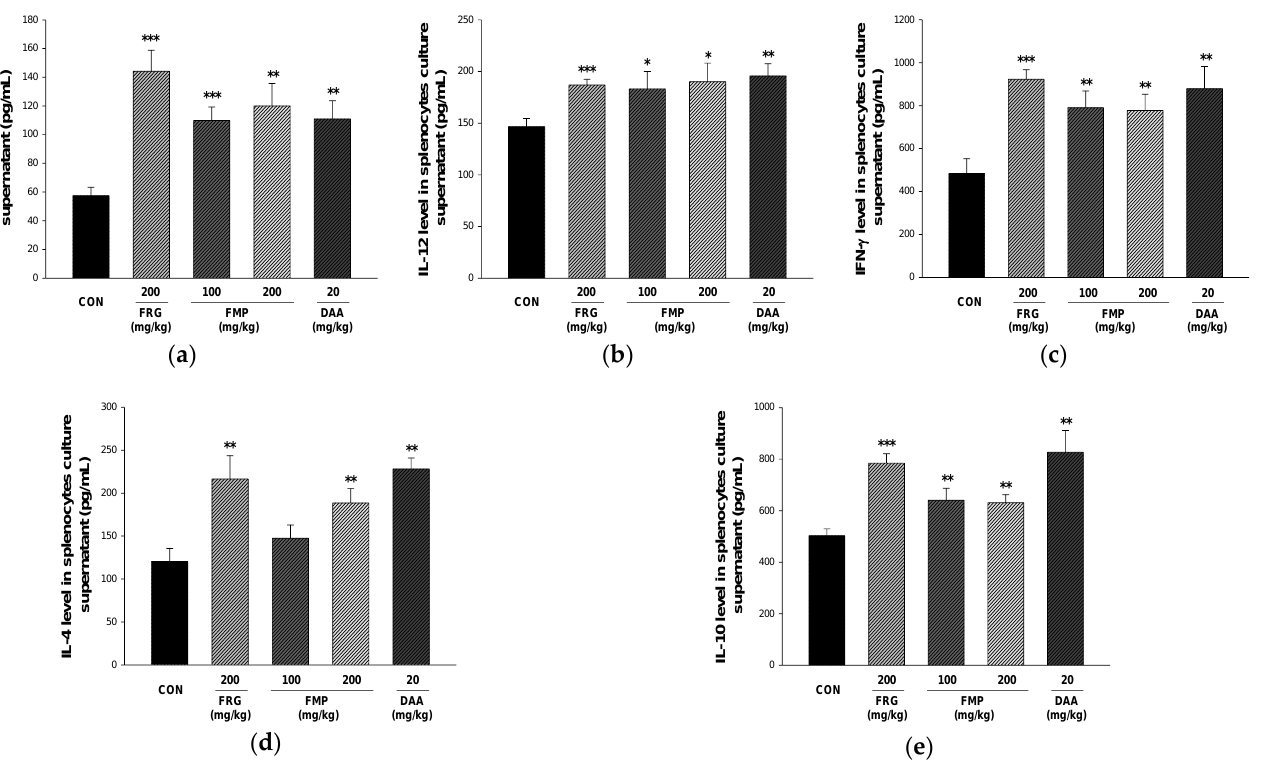
4 and IL-10) was higher in the FMP-treated group than in the untreated group.